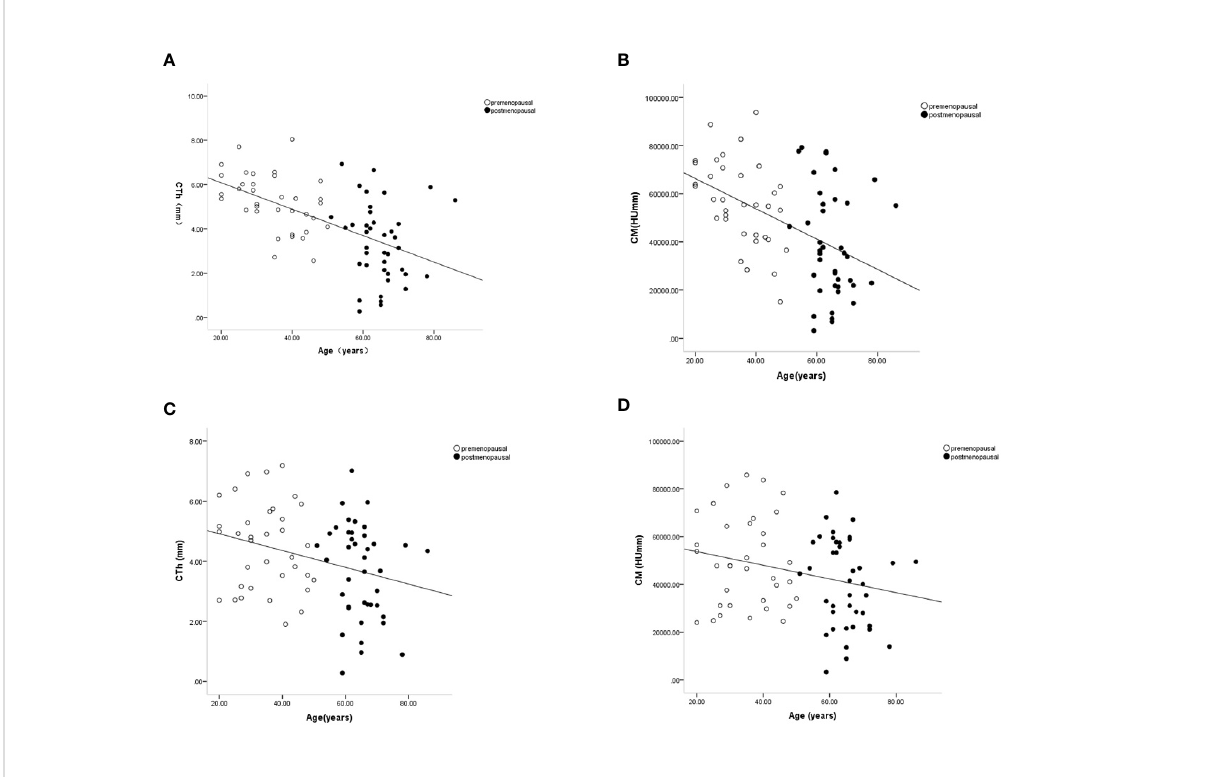
FIGURE 4 Age-related changes in cortical thickness and cortical mass surface density in the proximal part of the lateral wall (ROI 1) (A, B) and anterior wall (ROI 4) (C, D) . Premenopausal outcomes are indicated by open symbols, postmenopausal outcomes by full symbols. Solid lines represent the fi tted mean from the regression